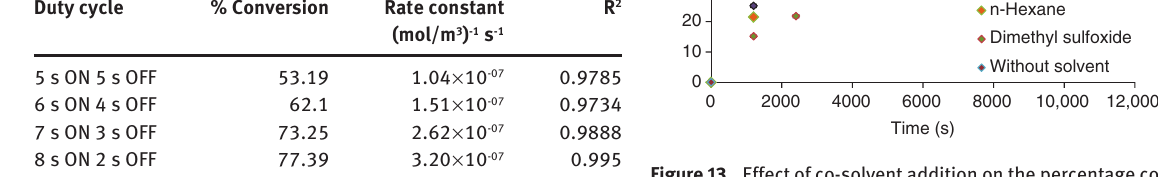
Figure 13 Effect of co-solvent addition on the percentage